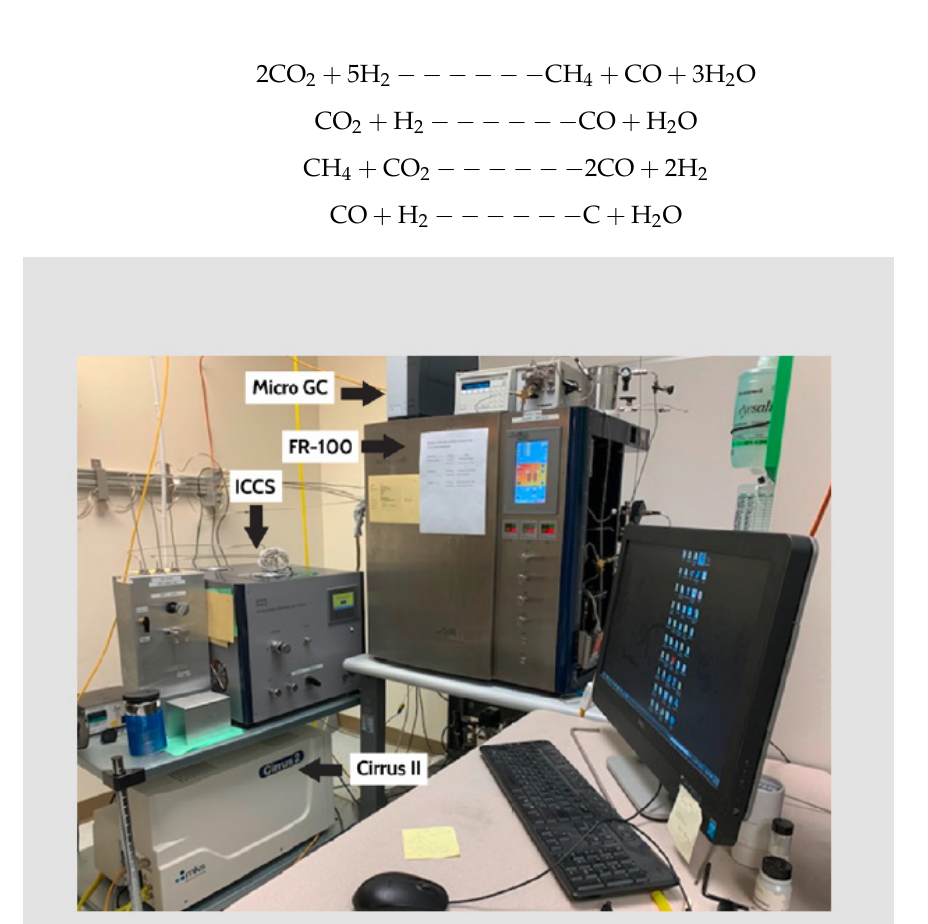
Figure 1. The set of 3 instruments connected together.